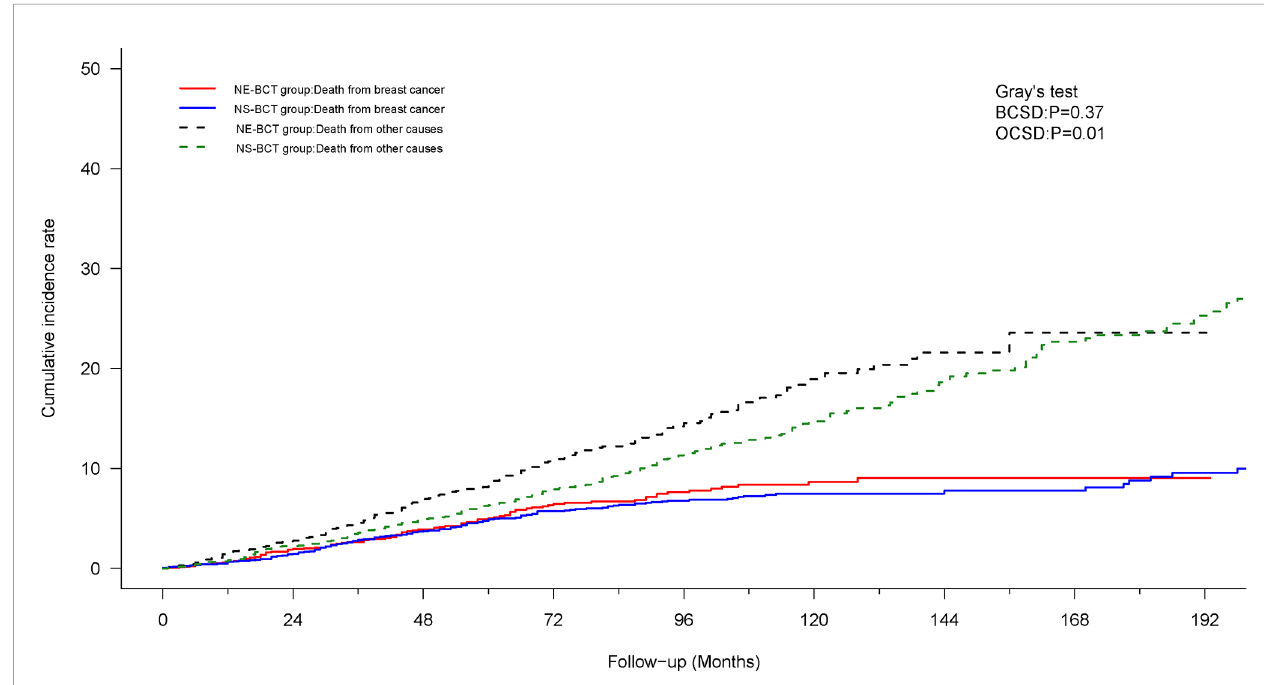
FIGURE 4 | Cumulative incidence of breast-cancer-speci fi c death (BCSD) and other causes of death (OCSD) in the NE-BCT and NS-BCT